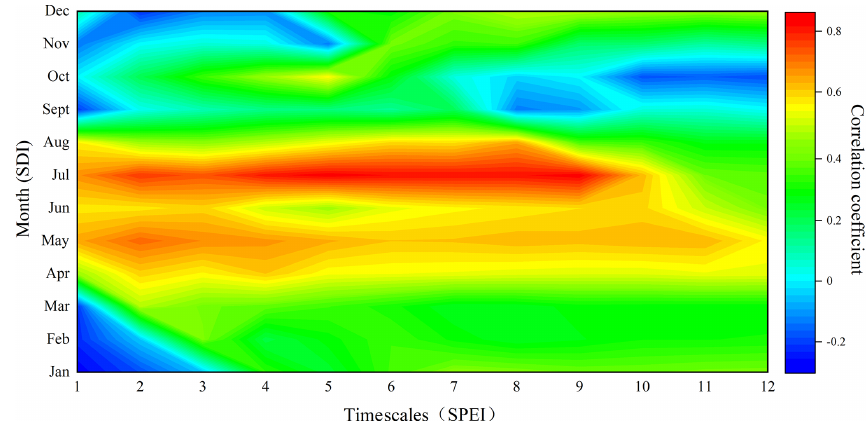
Figure 3. The correlation coefficients between monthly SDI and SPEI with different timescales at subbasin no. 6.